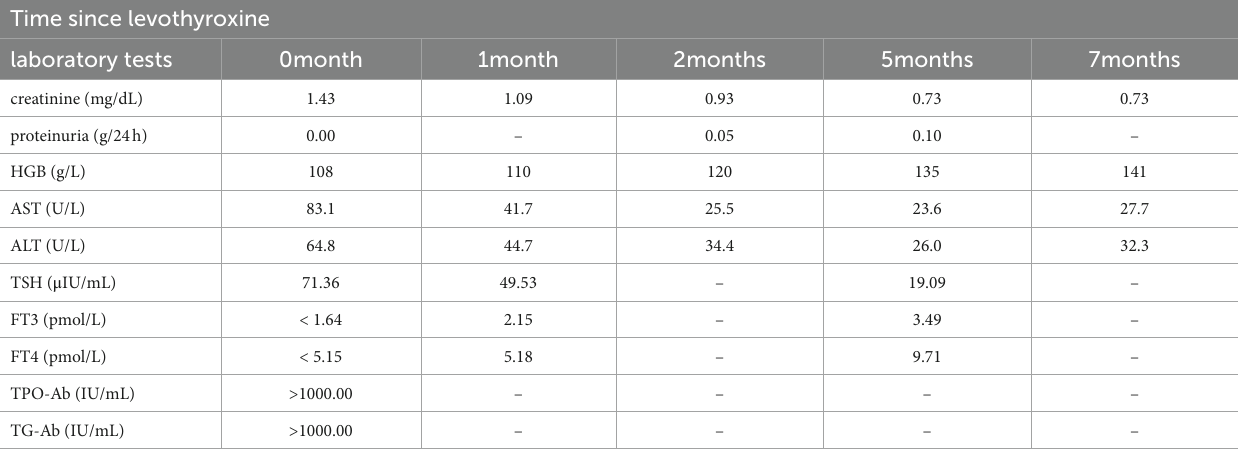
TABLE 1 Main laboratory tests during admission and follow-up.